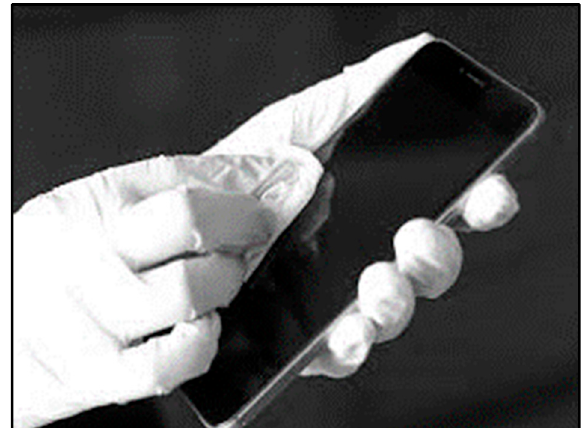
Figure A5. Surfaces.